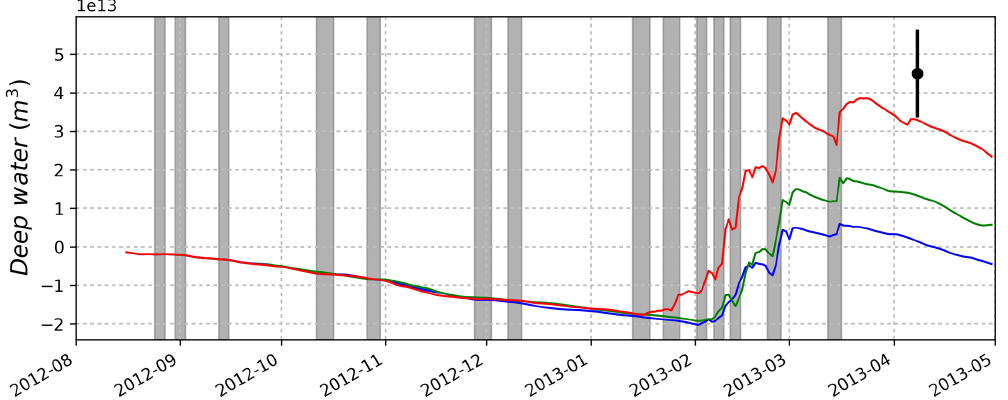
Figure 12. Time series of dense water volume (m 3 ) formed from 8 January 2012 for sea water density up to 29.11kgm − 3 computed for each simulation (COARE in blue, ANDREAS in green and MOON in red) in the convection area (as defined in Sect. 3). The black dot and error bar correspond to the dense water formation volume estimated from the observations by Waldman et al. (2016b) for the same density thresholds.The grey bars correspond to the strong wind periods (hourly wind speed > 15ms − 1